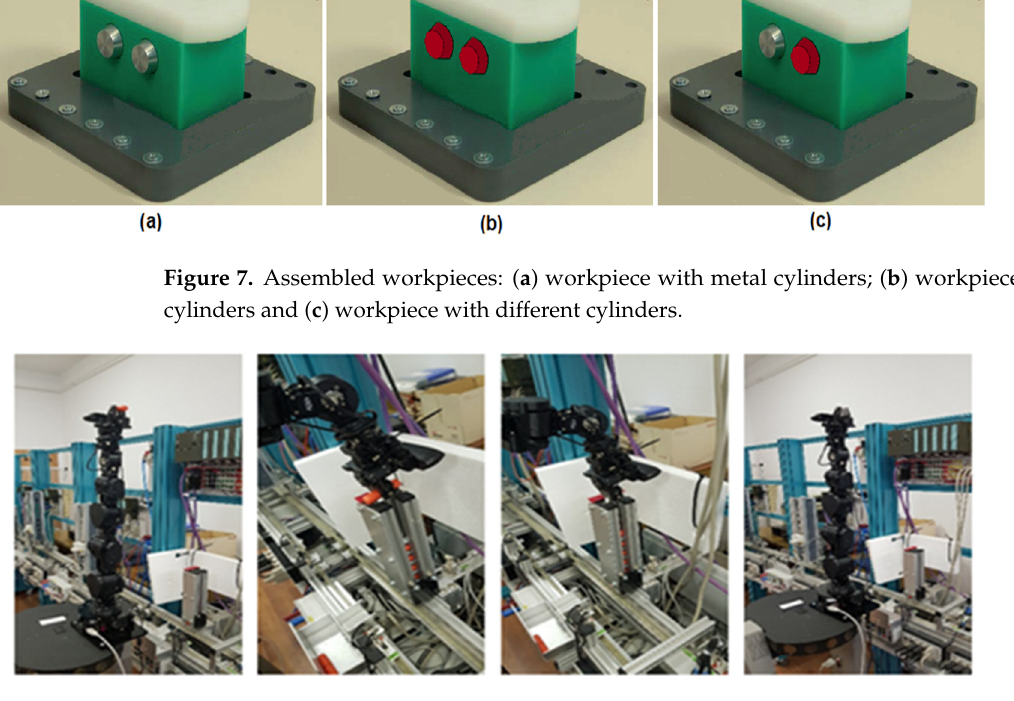
Figure 8. Real-time control of the ARS with RM Cyton.